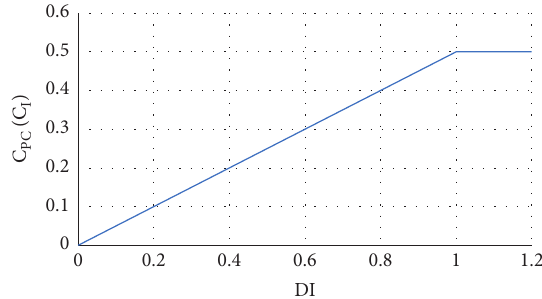
Figure 3: Loss of content cost as function of damage